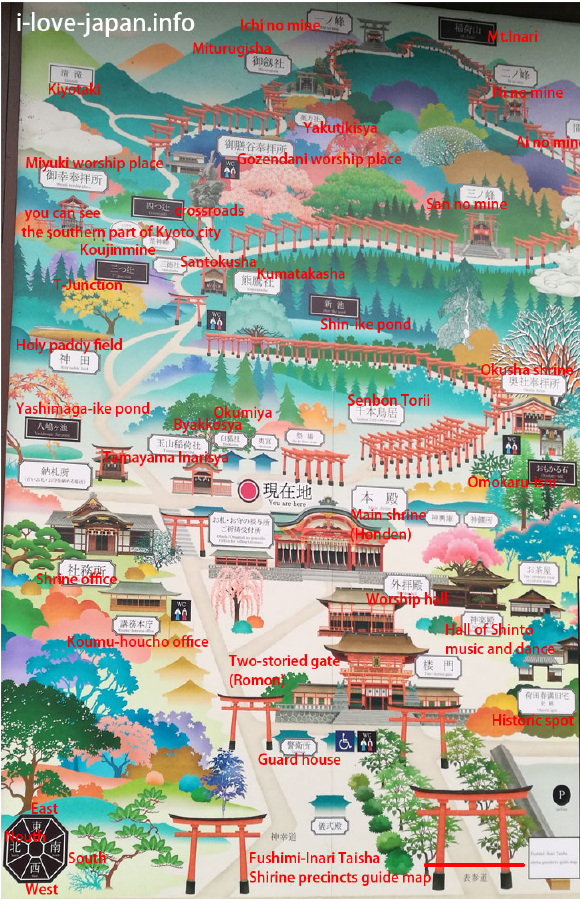
Figure 1: The layout of Fushimi Inari Shrine [2] contrary, the soundscapes of shrines and temples had not been affected by historical changes.